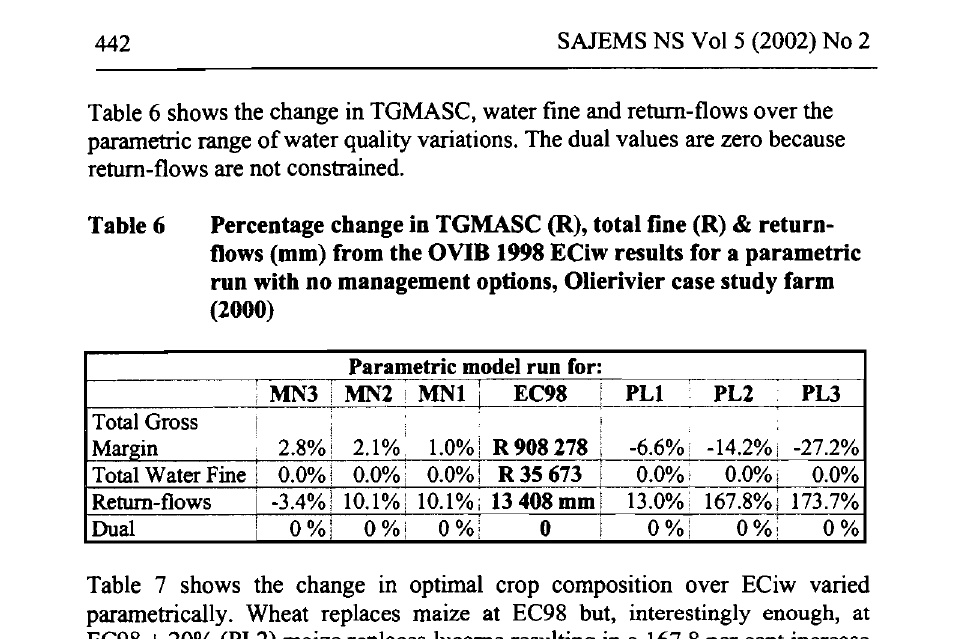
Optimal crop composition (hectares) for a parametric run with no management options using OVIB 1998 ECiw values as basis, Olierivier case-study farm